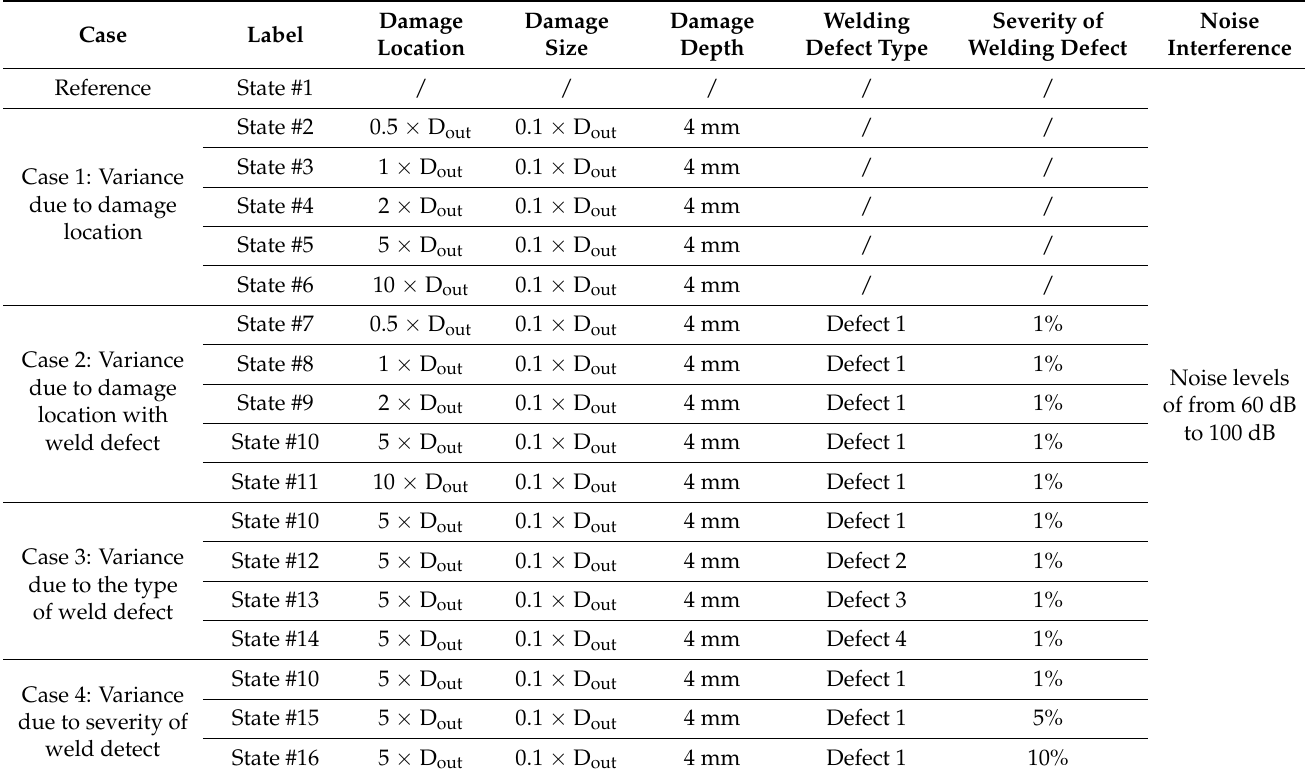
Table 1. Test matrix for computation